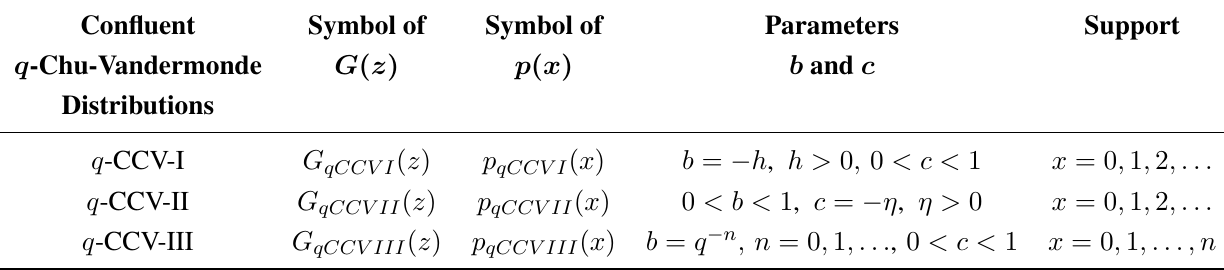
Table 1. Confluent q -Chu-Vandermonde